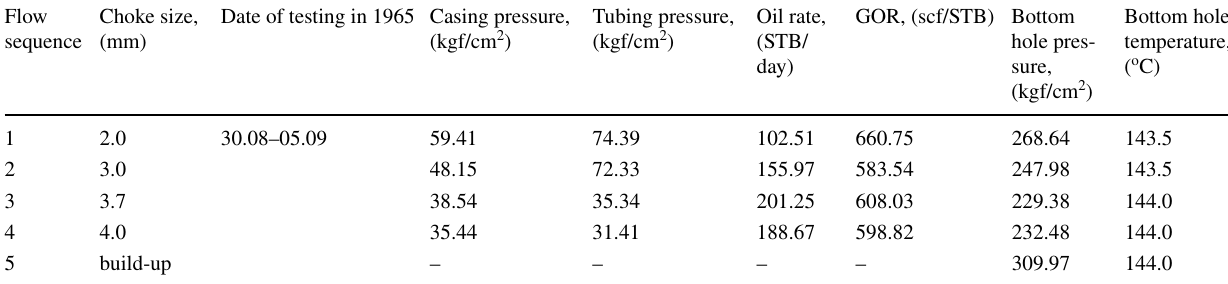
Table 15 Production test results of Well # 22 Praskoveyskaya